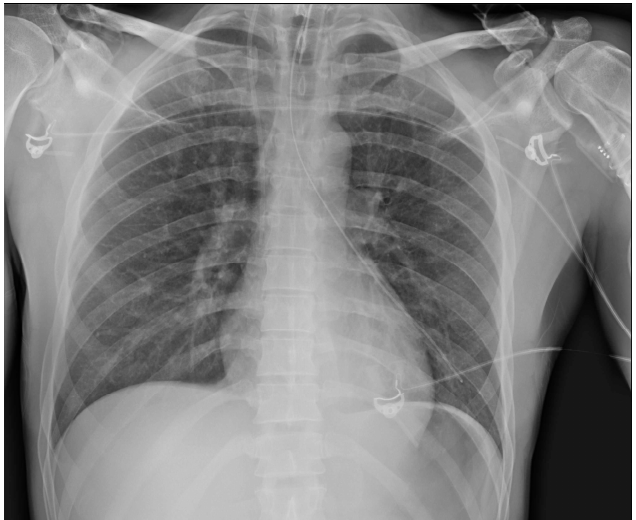
Figure 26. CXR of NG tube kinking shortly beneath the diaphragm, its tip projectively ending against the cardiac shadow ( a ); a right jugular CVC is also present. In the coronal view of the thoraco-abdominal CT scan of the same patient (before the NG tube was positioned) ( b ), it is possi- ble to appreciate a hiatal hernia (red asterisk), which explicates the previous finding.